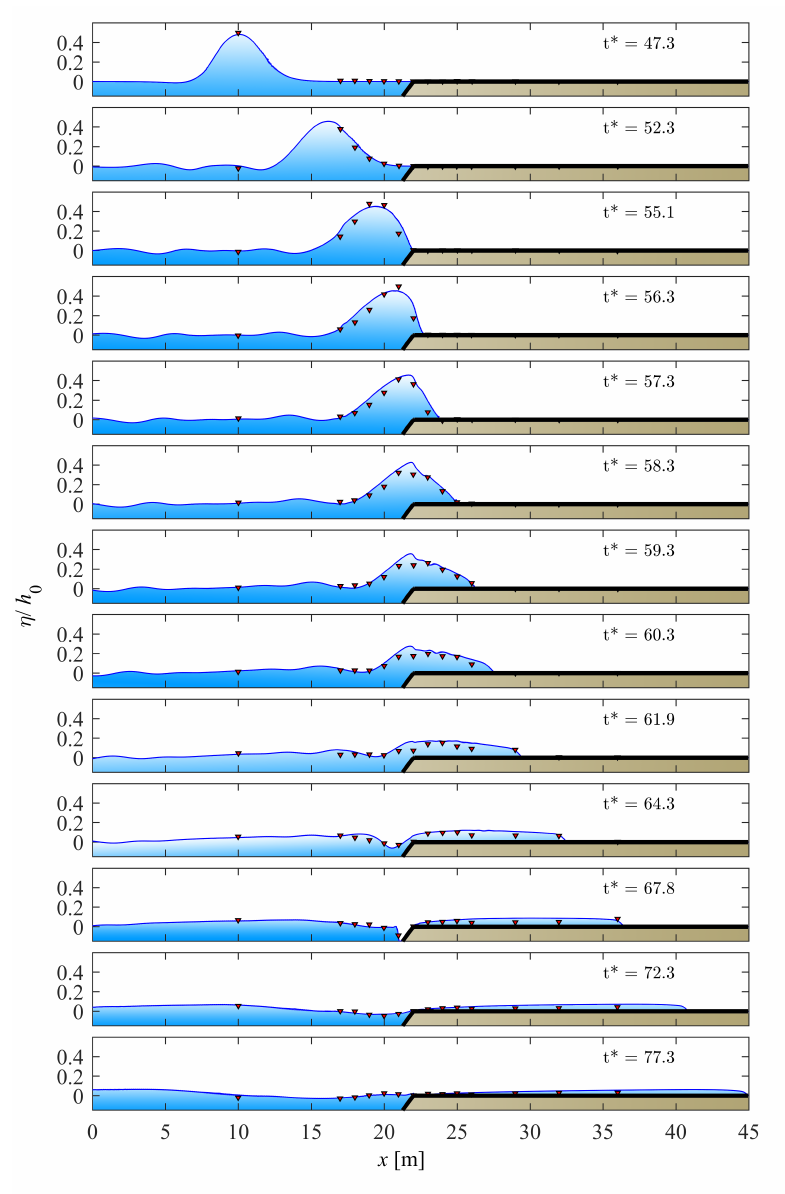
Figure 8. Surface elevations of solitary wave over a flat reef with H / h 0 = 0.5 and 1:5 slope. Solid blue lines are the weakly dispersive model results and the red triangles are measured data. Each subplot shows the results at a dimensionaless time